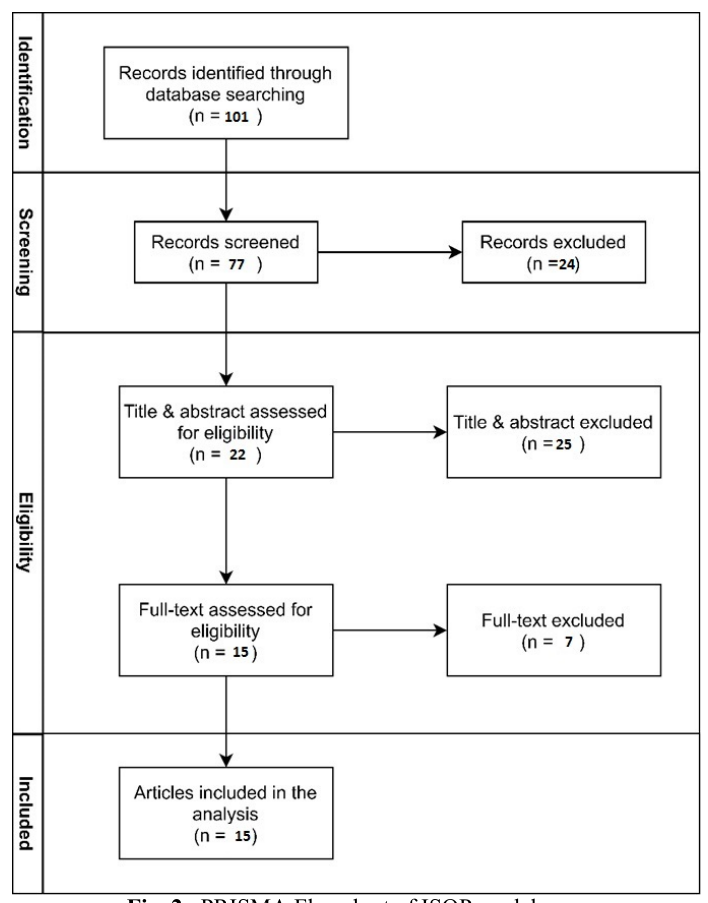
Fig. 2. PRISMA Flowchart of ISOP